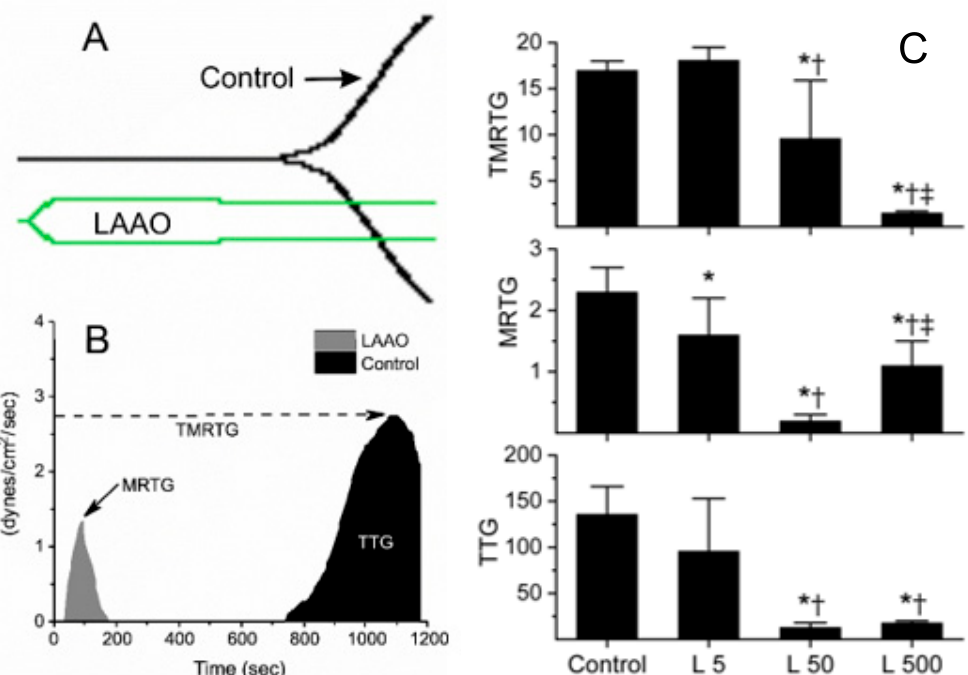
Figure 1. A comparison of traditional (panel A) and parametric (panel B) outputs with a control plasma sample (black trace) and a sample with 500 nM L-amino acid oxidase (LAAO) addition (green and gray traces) are provided. The concentration-response of LAAO on coagulation (panel C) is also displayed. The run time was 20 min for all outputs, and for clarity, the axes of panel A were omitted. Panels B and C: TMRTG (dashed line, arrow) = minutes; MRTG (solid line, arrow) = dynes/cm 2 /sec; TTG (white inset) = dynes/cm 2 . Panel C data is displayed as mean ± SD. Control = 0 nM LAAO; L5 = 5 nM LAAO; L50 = 50 nM LAAO; L500 = 500 nM LAAO. * p < 0.05 versus Control; † p < 0.05 versus L5; ‡ p < 0.05 versus L50.